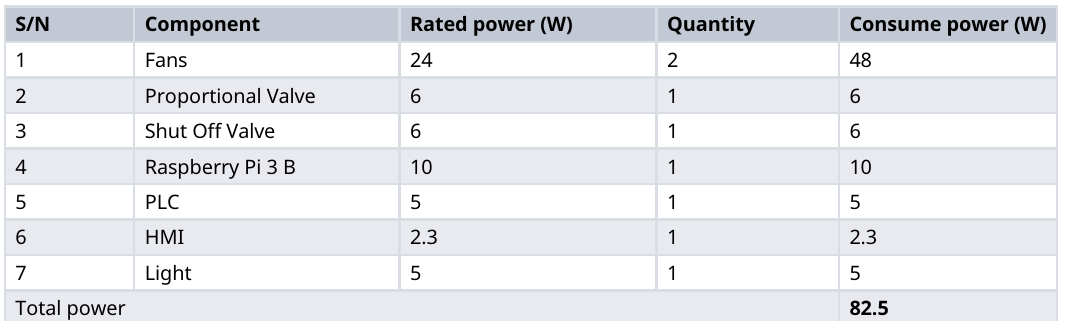
Table 3. System power